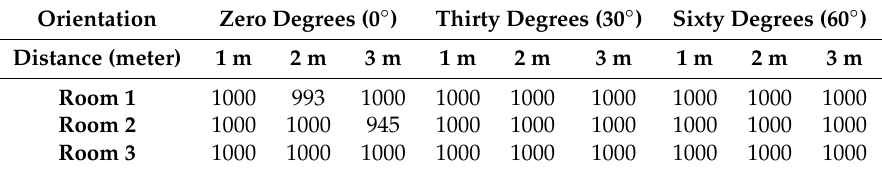
Figure 3. Sound activity detection flow diagram. Table 1. Number of audio signals recorded at each position in all three rooms.